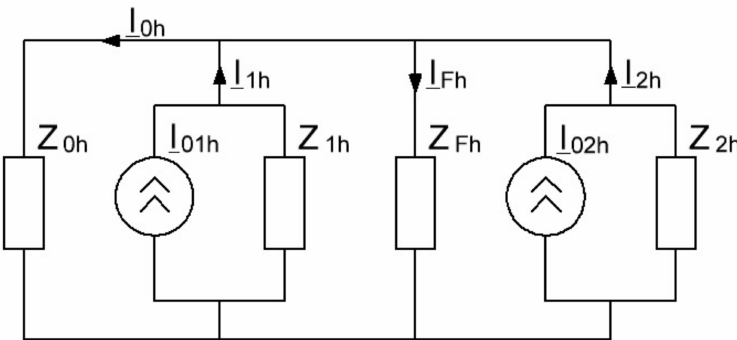
Figure 2. The scheme for identification nonlinear load current at harmonic frequencies of h